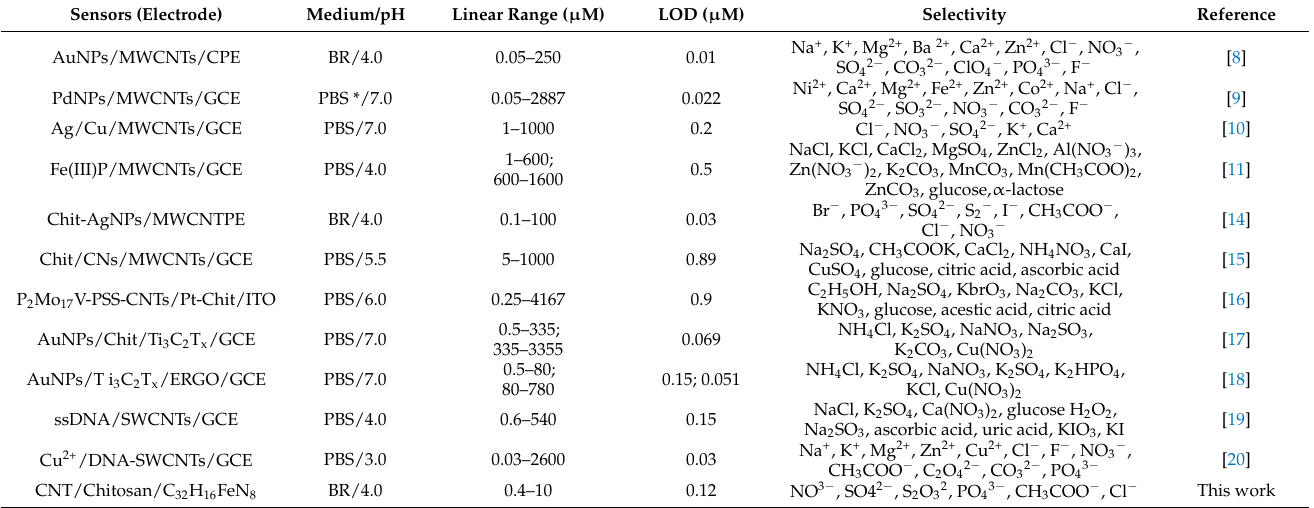
Table 2. LOD for different sensors in different buffer solutions and pH. All sensors in Table 2 were used for NO 2 detection in solutions with either BR or PBS electrolytes. In the Selectivity column are presented the interferent ions.